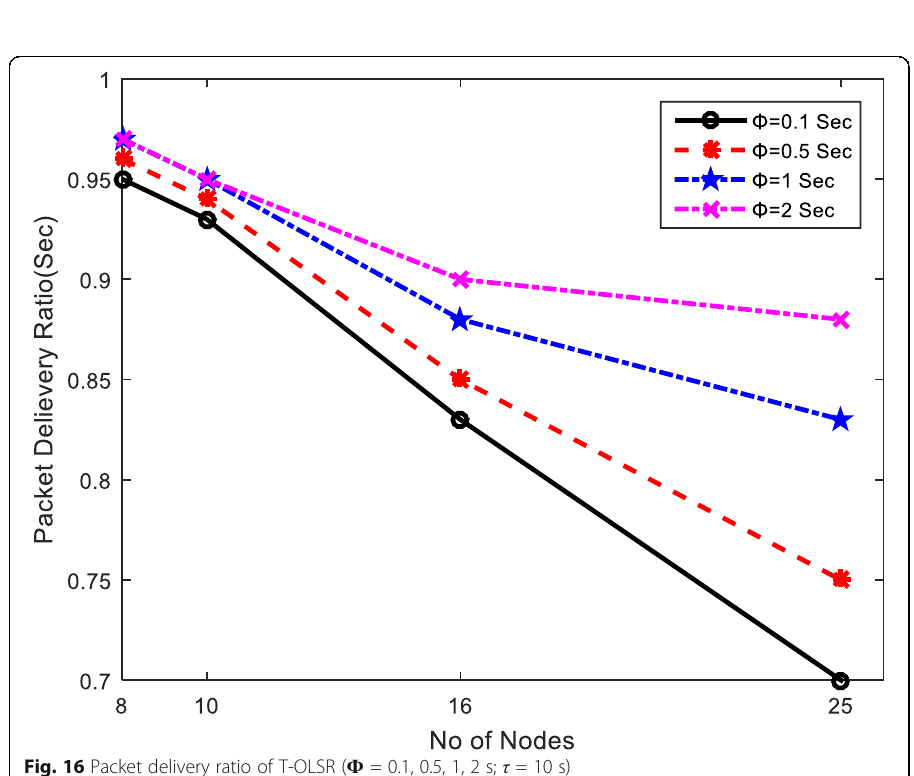
Fig. 16 Packet delivery ratio of T-OLSR ( Ф = 0.1, 0.5, 1, 2 s; τ = 10